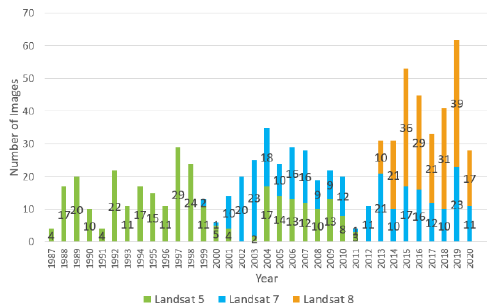
Figure 3. Number of Landsat satellite images used for spectral unmixing per